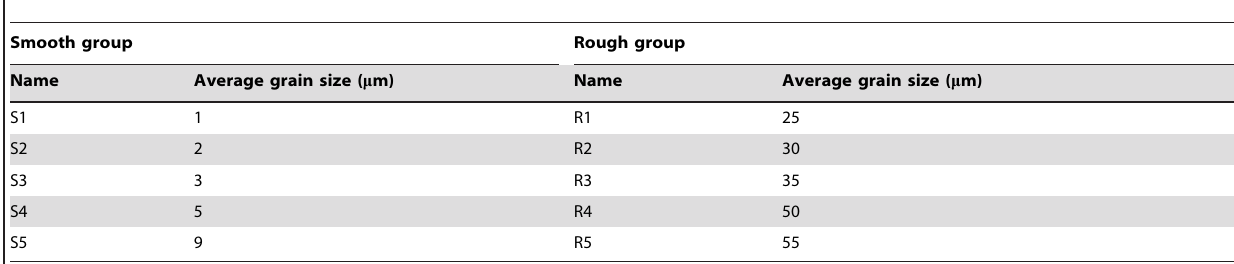
Table 1. Average grain size of the stimuli.